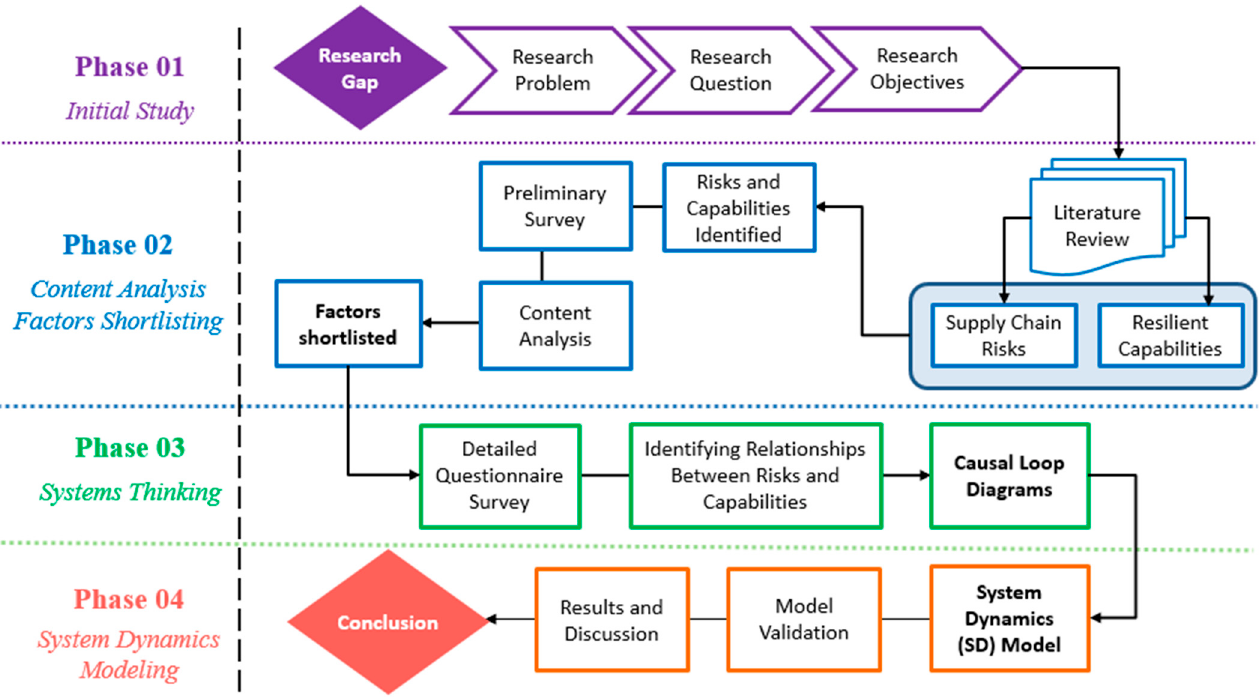
Figure 2. Schematic diagram of research methodology.